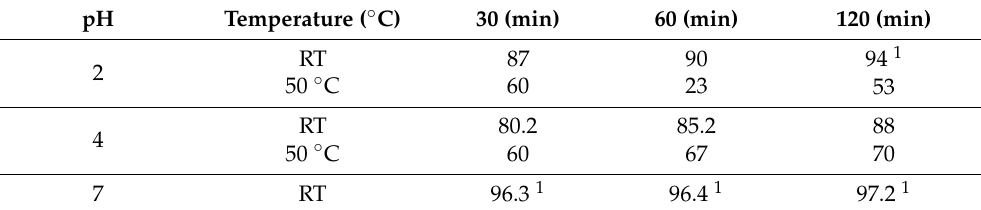
Table 1. Percentage (%) of radiolabeling yield of [ 99m Tc]Tc-DPD-Fe 3 O 4 DMCAs incubated